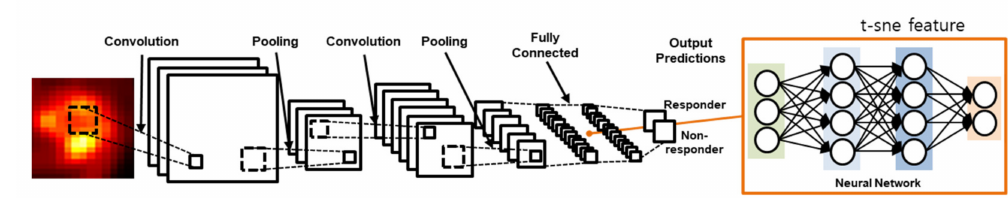
Figure 1. The 18 F-FDG 2D CNN model for predicting the response to neoadjuvant chemotherapy. The 2D CNN model consisted of two convolution layers and two fully connected